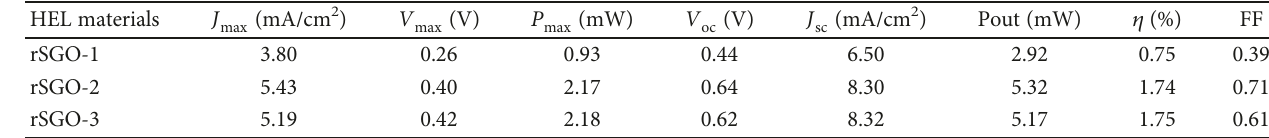
Table 3: The parameters of modelled devices via Silvaco TCAD.